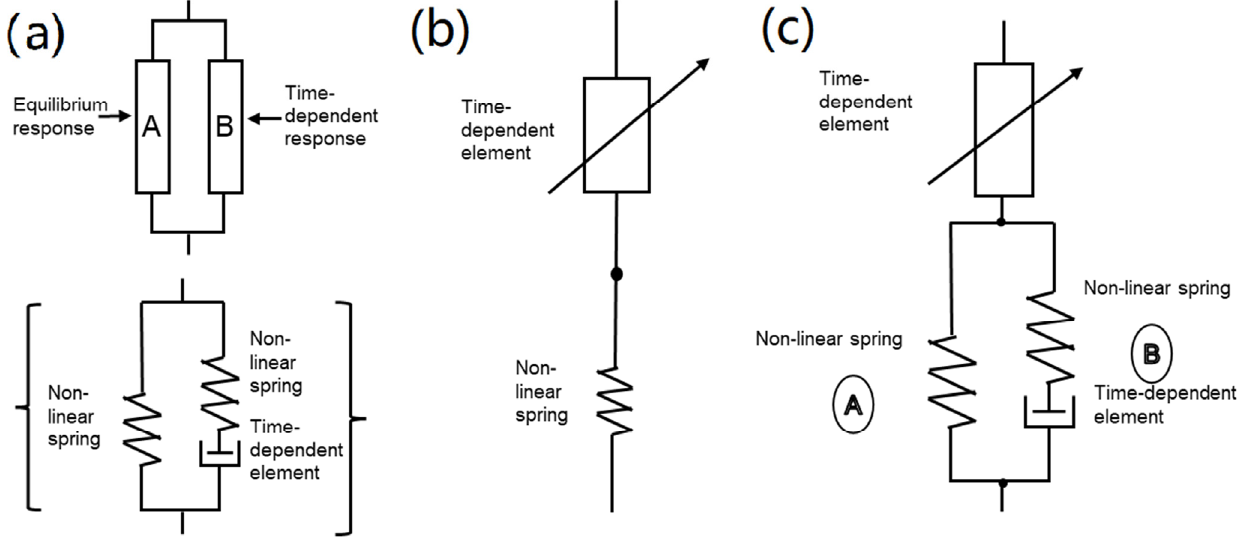
Figure 15. ( a ) Total deformation resistance is decomposed into the equilibrium resistance A and equilibrium response B [78], ( b ) schematic representation of thermo-visco-elastic model [79], and ( c ) schematic representation of thermo-visco-elastic model [80].